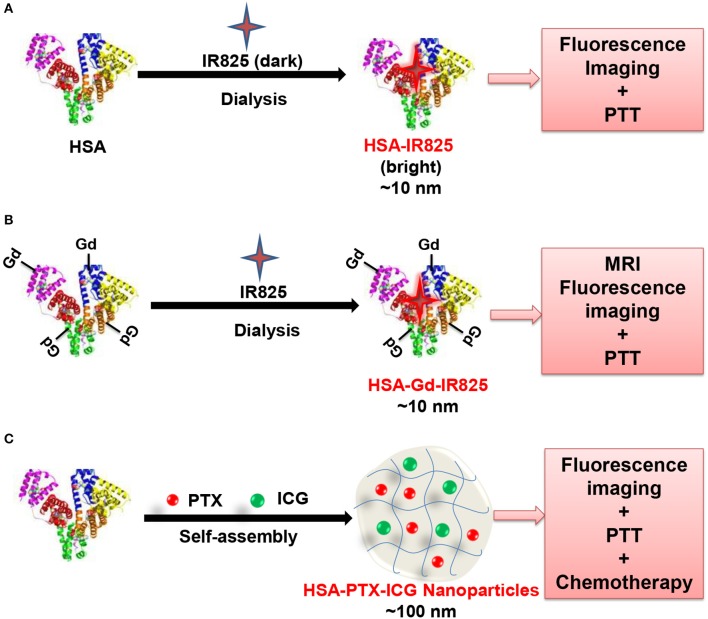
Schematic illustration of the fabrication of HAS-IR825 complex (A) (Chen et al., 2014c), HAS-Gd-IR825 complex (B) (Chen et al., 2014a), and HSA-ICG-PTX nanoparticles (C) (Chen et al., 2015a).